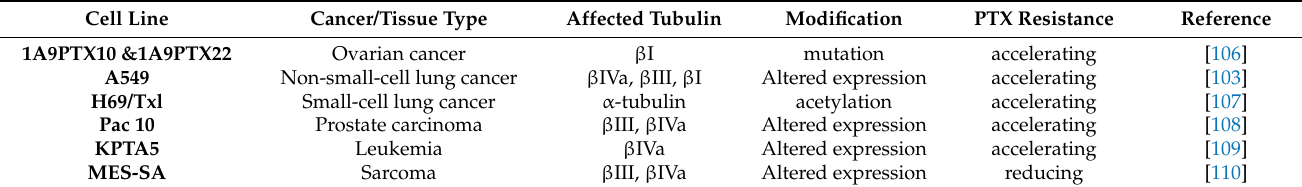
Table 1. PTX-resistant cell lines with modifications and alternations in